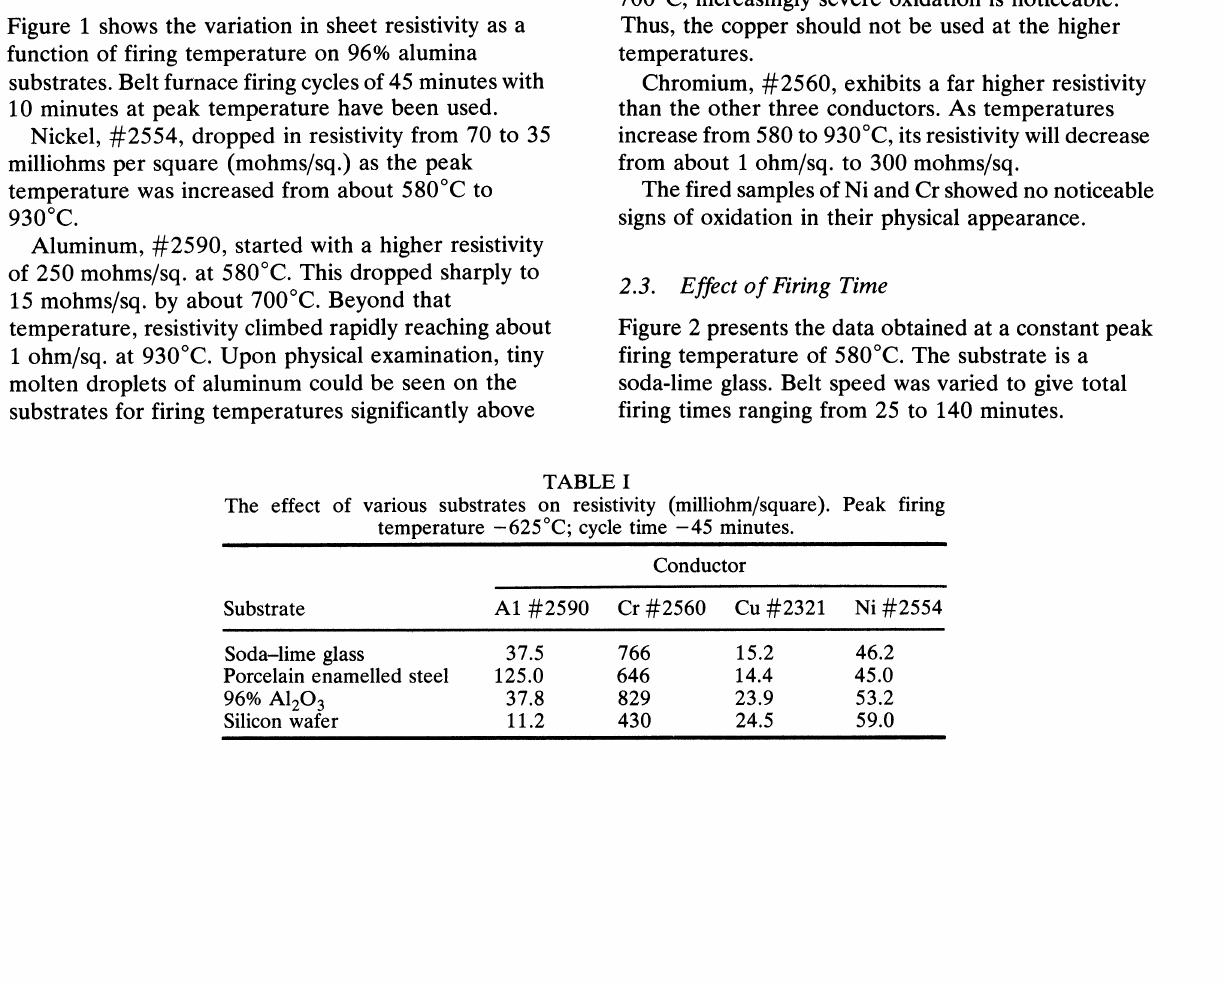
FIGURE Resistivity vs. firing temperature.